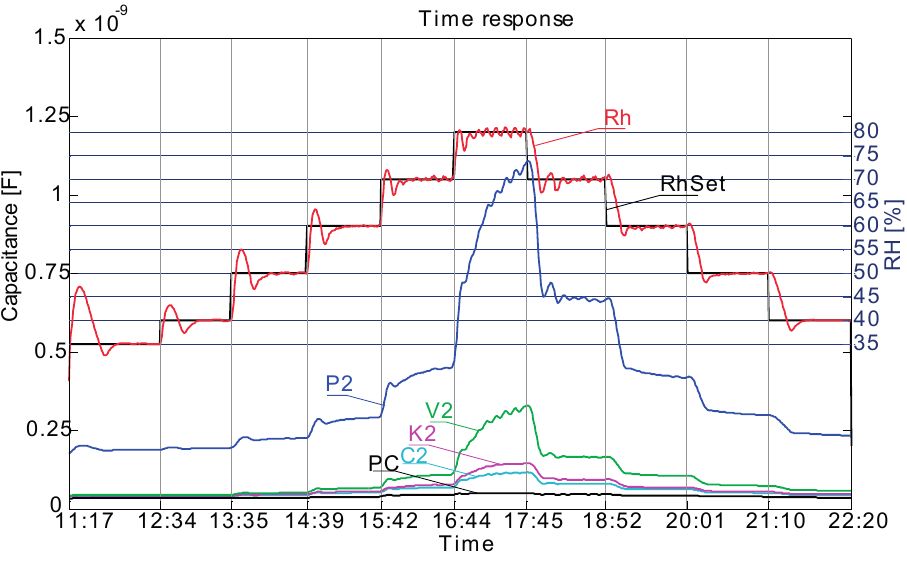
Figure 6. Comparison of the same dimension capacitors (2 × 2 cm); P2—perforated flat plate capacitor (recycled paper), C2—comb capacitor (recycled paper), K2—comb capacitor (cardboard), PC—comb capacitor (poly-carbonate), V2—comb capacitor (food packaging paper), RhSet—humidity chamber set value, Rh—humidity chamber measured